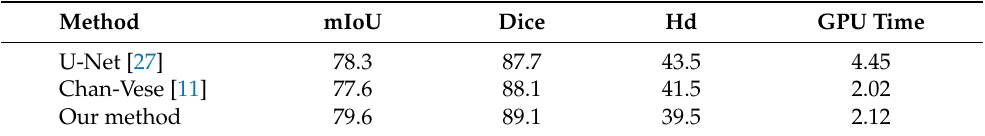
Table 2. Accuracies of segmentations models on a third of labeled data from BraTS Dataset [28].